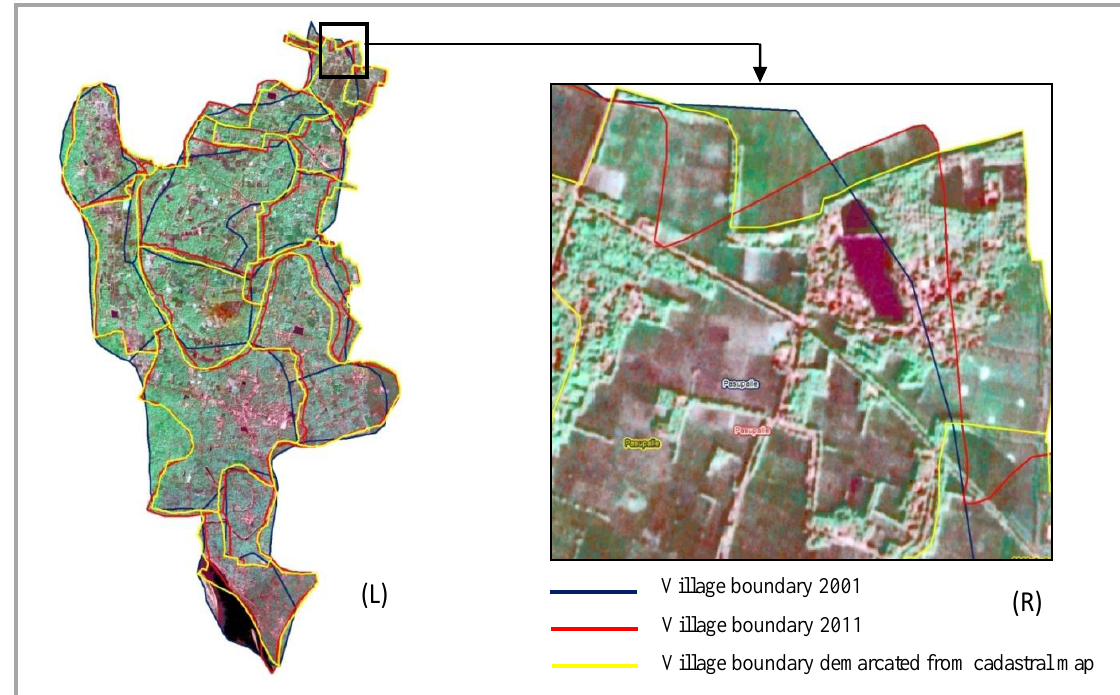
Figure 13: (L) Village boundaries (2001, 2011, and derived from cadastral map) overlaid on HRSI and (R) Boundaries overlaid on Region of Interest